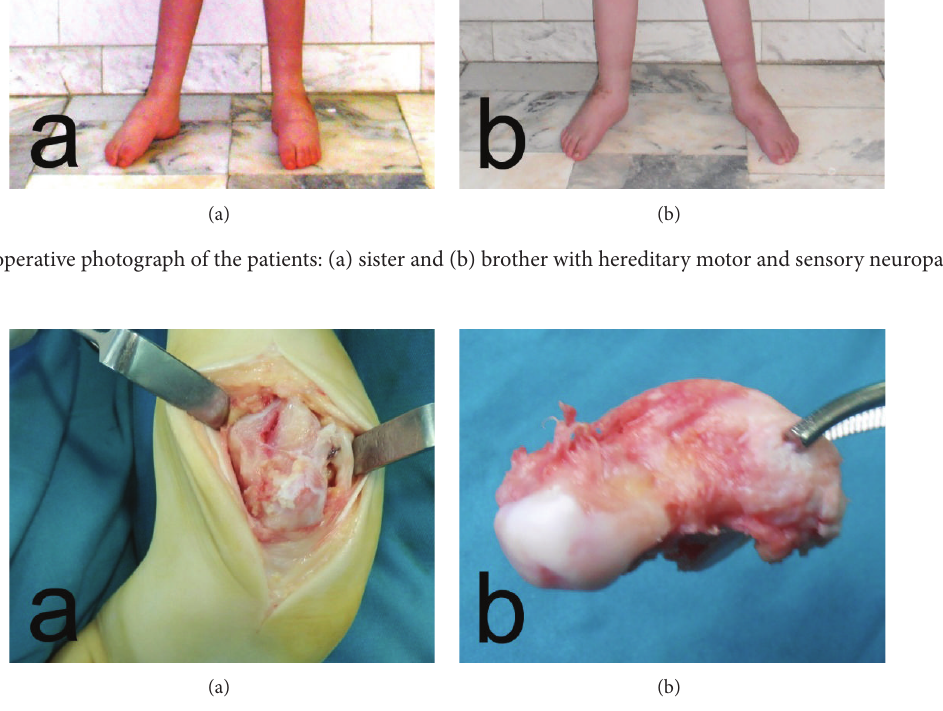
Figure 6: Intraoperative photograph (a) and photograph showing severe degenerative changes of the talus articular cartilage